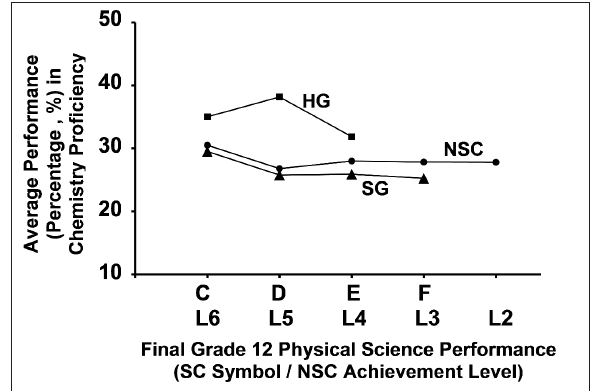
Average performance of students in the Extended BSc Programme in the Chemistry proficiency test in relation to